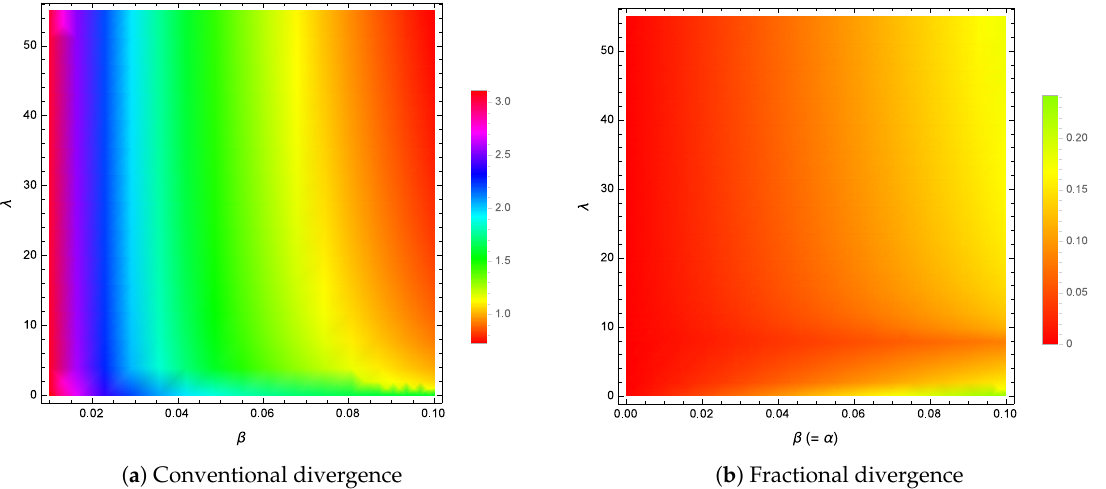
Figure 2. For x 0 “ 0.01, the ( a ) conventional and ( b ) fractional divergence is shown,